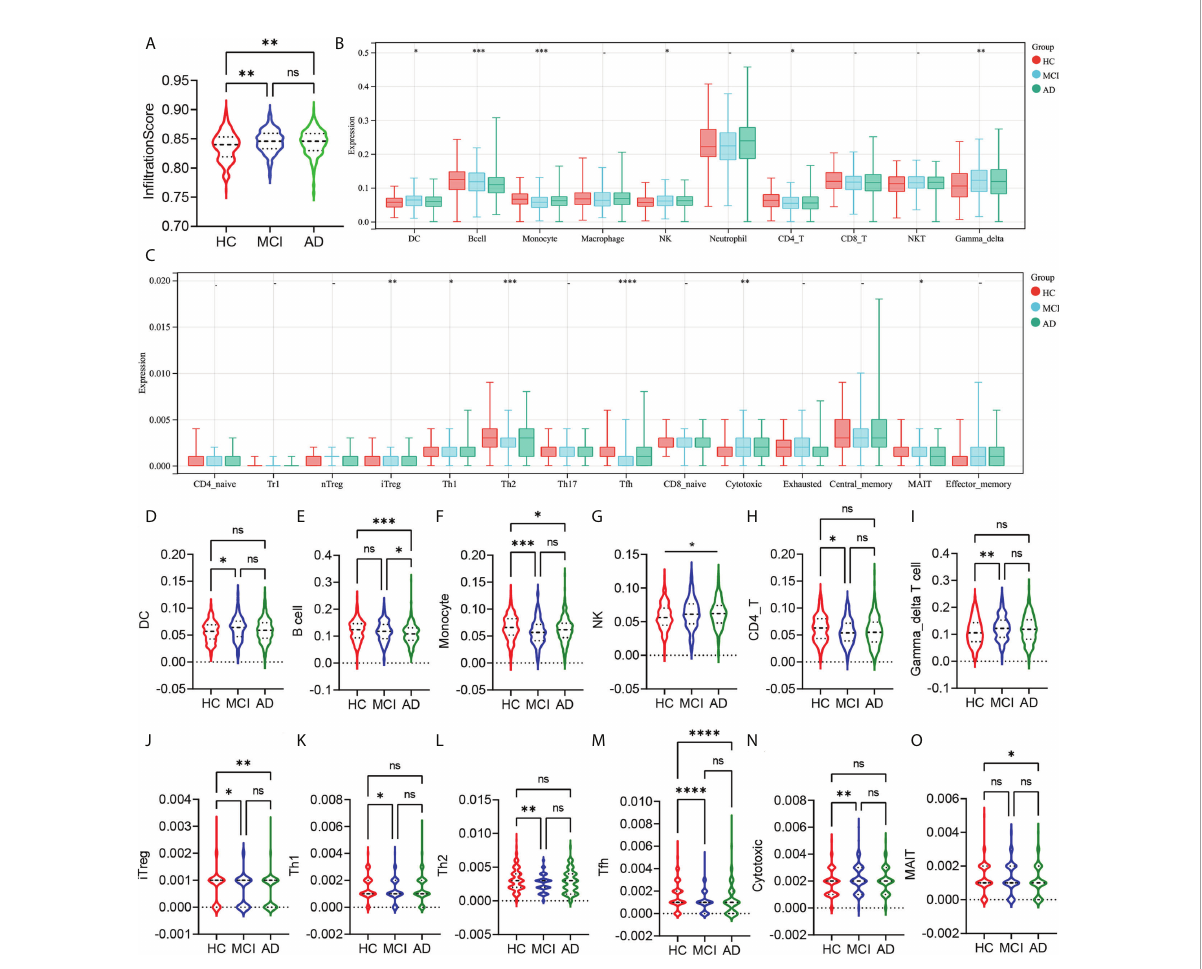
FIGURE 1 Analysis of the peripheral immune cells ’ abundance differences between HC, MCI, and AD groups. (A) The i n fi ltration score difference between HC, MCI, and AD groups. (B) The abundance difference of DC, B cells, monocytes, macrophages, NK, neutrophils, CD4 T cells, CD8 T cells, NKT, and g - d T cells between the HC, MCI, and AD groups. (C) The abundance difference of CD4 + naïve, induced regulatory T (iTreg), natural regulatory T (nTreg), type 1 regulatory T (Tr1), Th1, Th2, Th17, T follicular helper (Tfh), central memory T (Tcm), effector memory T (Tem), CD8 + naïve, cytotoxic T (Tc), mucosal-associated invariant T (MAIT), and exhausted T (Tex) between HC, MCI, and AD groups. (D – O) Violin plots show statistically different immune cell abundances between HC, MCI, and AD. The red color represents the HC group, the blue color represents the MCI group, and the green color represents the AD group. p -values between each group are shown at the top of the fi gure. HC, healthy control; MCI, mild cognitive impairment; AD, Alzheimer ’ s disease. p < 0.05 was considered to be statistically signi fi cant. * p < 0.05; ** p < 0.01; *** p < 0.001; ****p<0.0001; ns, no statistical